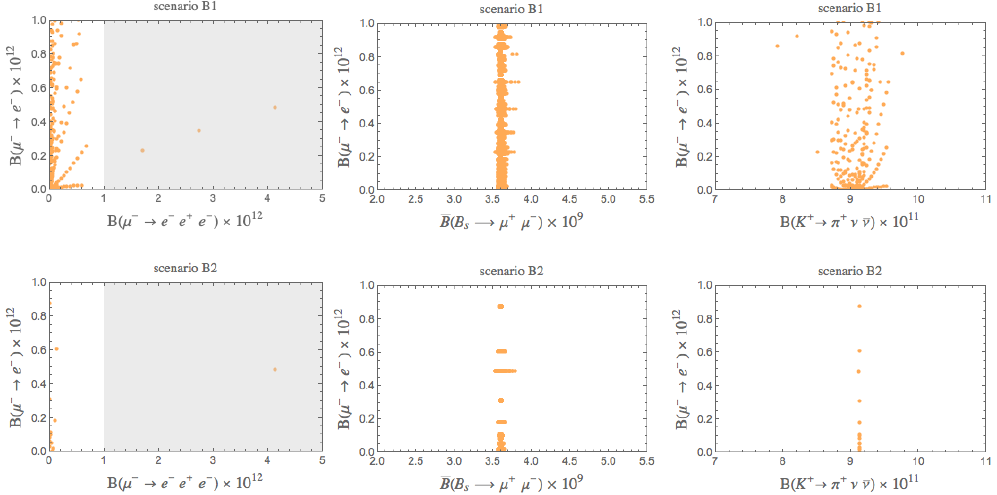
Figure 14 . Scenarios B1 (upper plots) and B2 (lower plots). Correlation between B ( (cid:22) (cid:0) ! e (cid:0) ) and B ( (cid:22) (cid:0) ! e (cid:0) e + e (cid:0) ) (left panels). The gray shaded region is excluded by the experimental bound B ( (cid:22) (cid:0) ! e (cid:0) e + e (cid:0) ) < 1 (cid:1) 10 (cid:0) 12 . Correlations between B ( (cid:22) (cid:0) ! e (cid:0) ) and (cid:22) B ( B s ! (cid:22) + (cid:22) (cid:0) ) (middle panels) and between B ( (cid:22) (cid:0) ! e (cid:0) ) and B ( K + ! (cid:25) + (cid:23) (cid:22) (cid:23) ) (right panels).